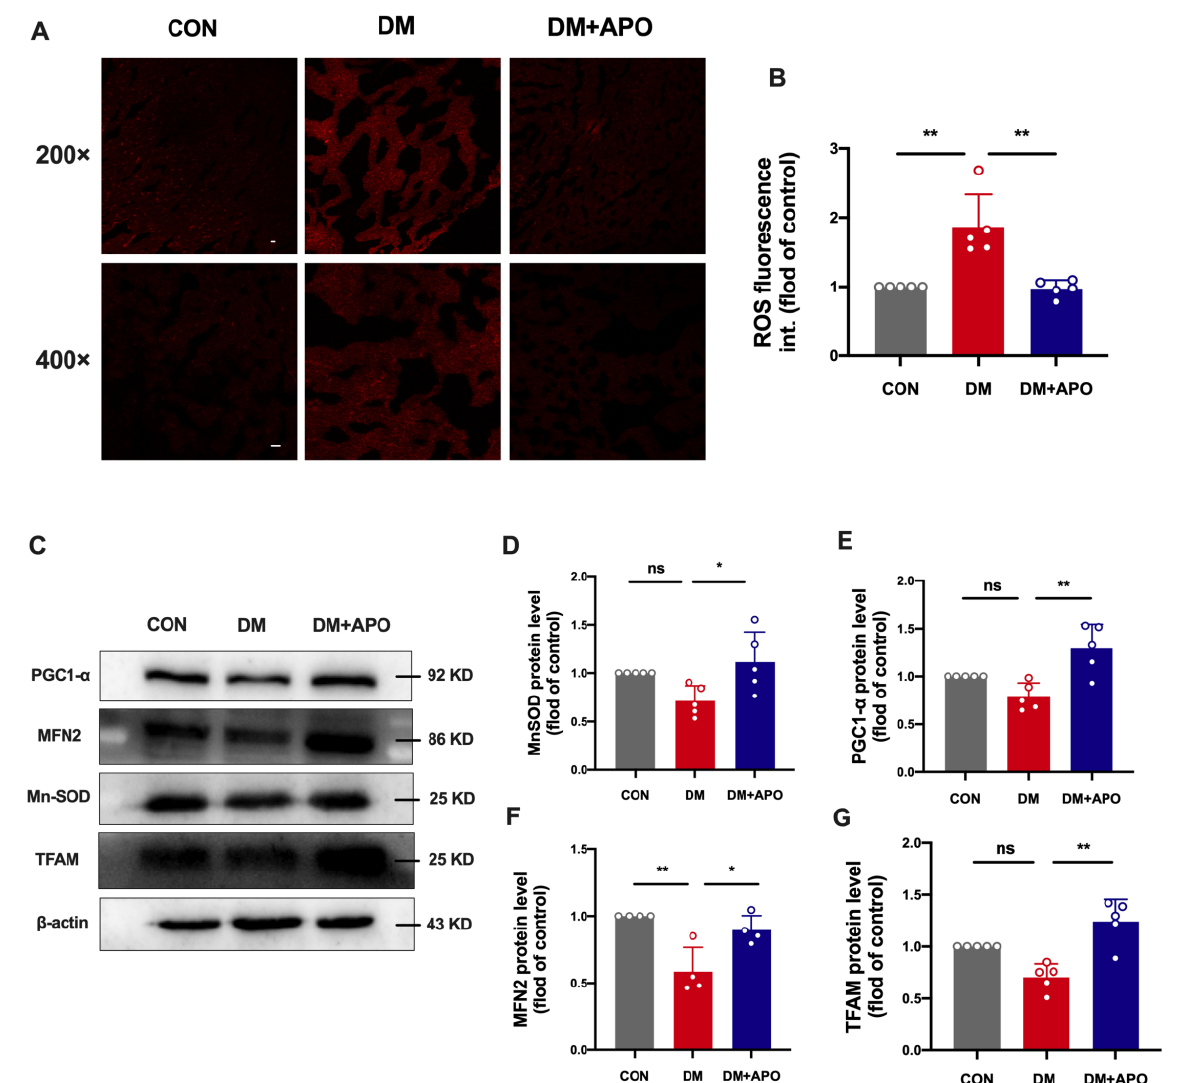
Figure 3. Apocynin decreases reactive oxygen species (ROS) and improves mitochondrial function of diabetic cardiomyopathy. ( A , B ) Production of ROS in ventricular tissues. Scale bar, 20 µ m. ( C ) Expression of PGC1- α , Mn-SOD, TFAM, and MFN2 among the 3 groups. ( D – G ) Quantification of PGC1- α , Mn-SOD, TFAM, and MFN2 in (C). Data are mean ± SD; n = 5 mice per group; * p < 0.05, ** p < 0.01.